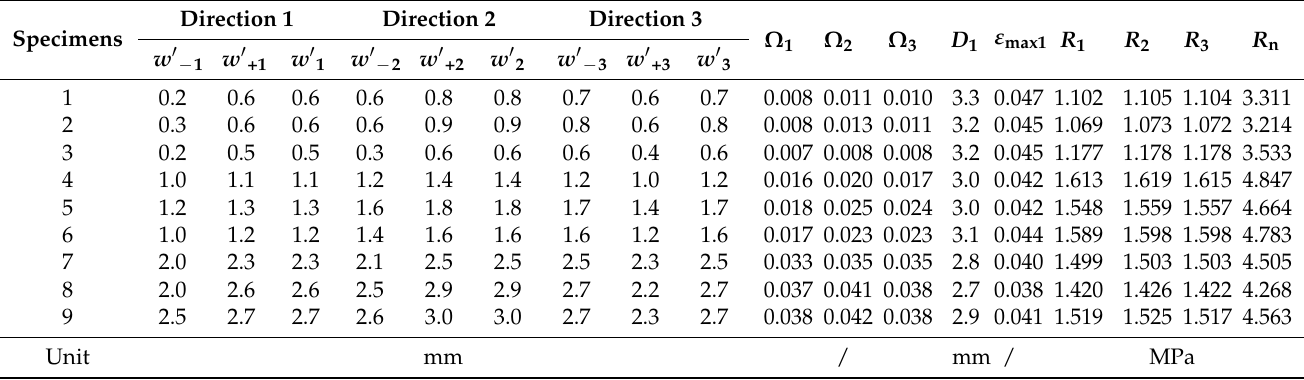
Table 2. Mortar damage and resistance